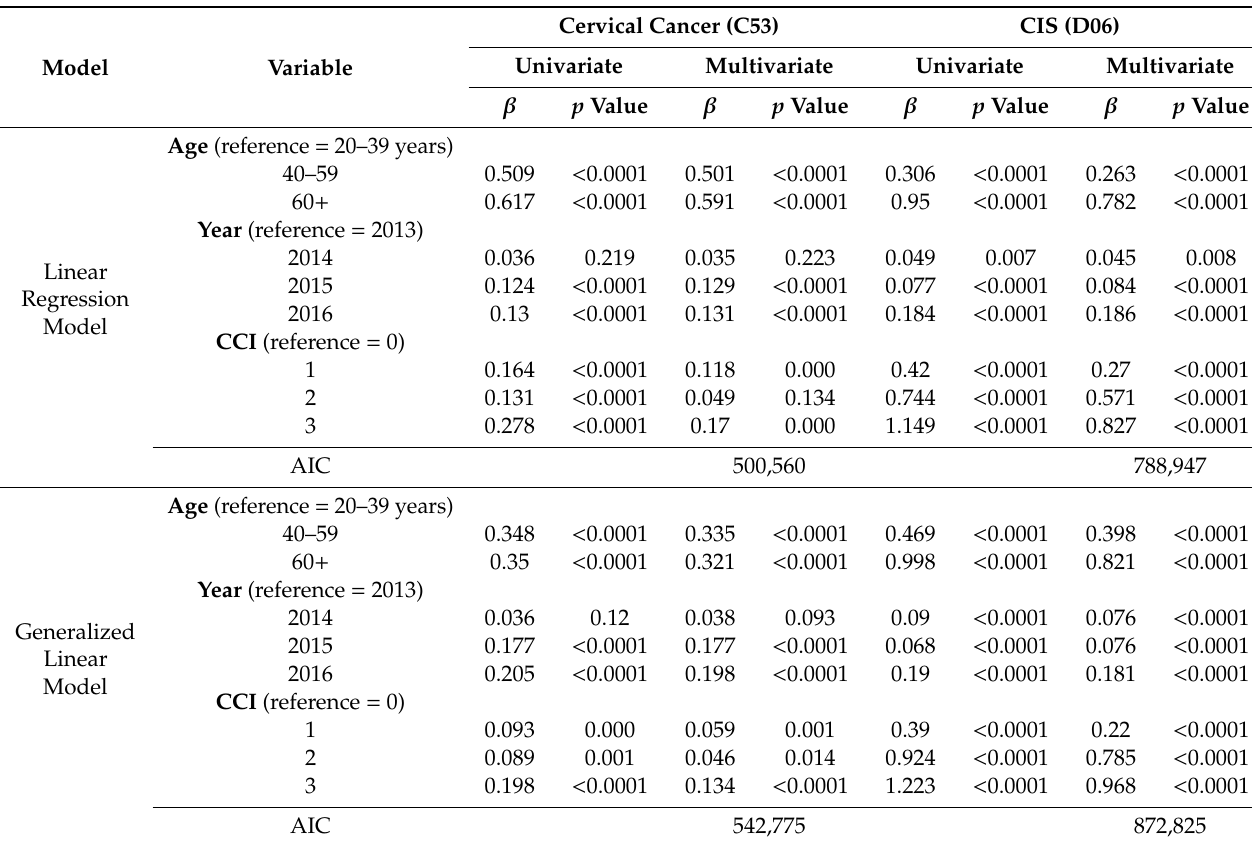
Table 2. Linear regression model and generalized linear model for incidence-based medical